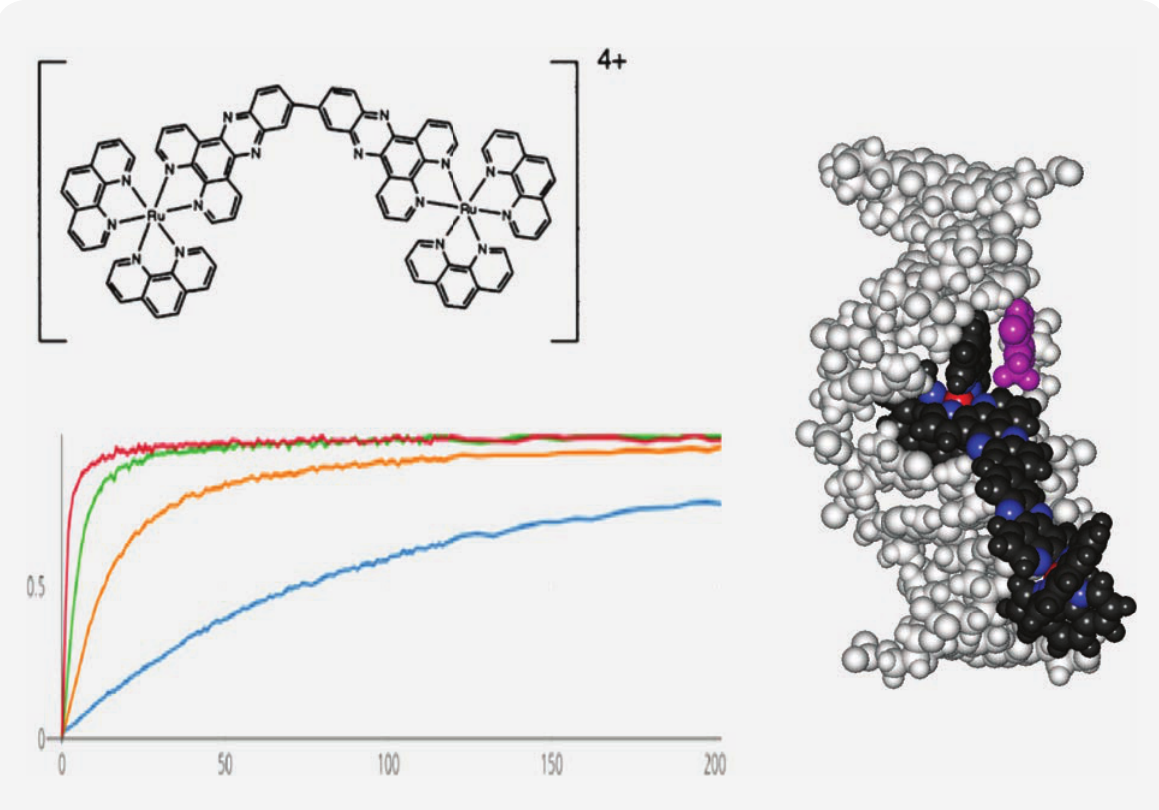
Figure 10. Left: Thread-intercalation of bulky bimetallic complex is catalyzed by PEG (A). Curves showing intercalation rates: 0 (blue), 20 (orange), 30 (green) and 40 % PEG (red). Figure adapted from results kindly provided by Dr Bobo Feng (Feng et al, to be published). Right: Hydrophobic phen- anthroline on complex self-catalyzes passage through DNA by forming a transition state by stacking to a DNA base (thymine). Figure kindly provided by Prof Per